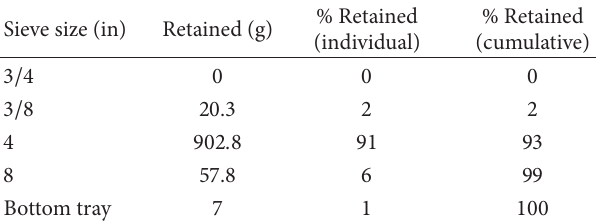
Table 2: Sieve analysis of